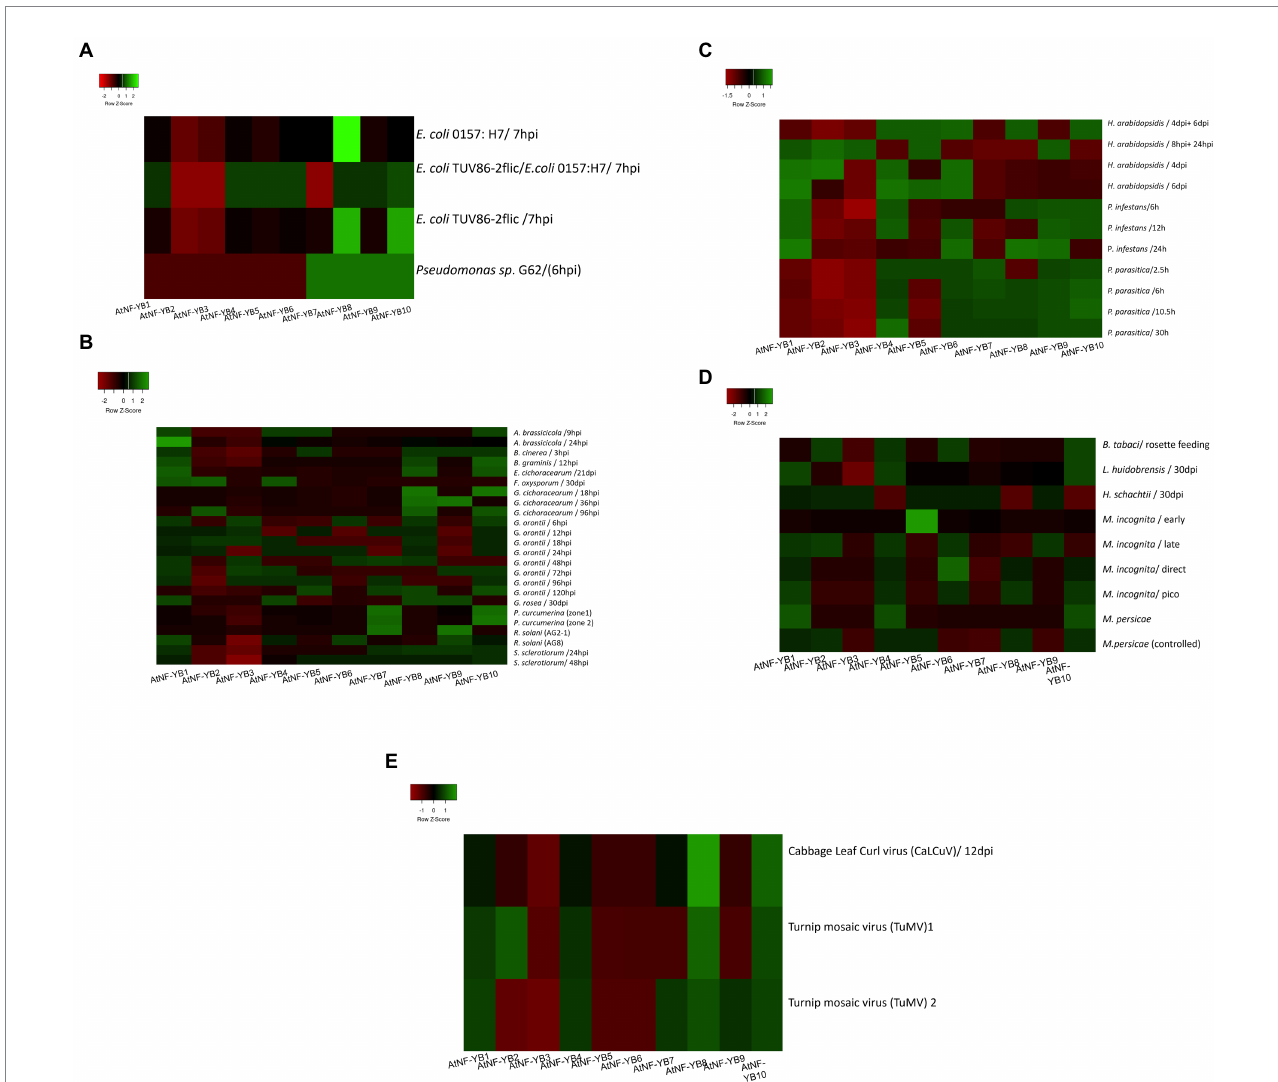
FIGURE 7 (A) Heat map showing the expression profiles of 10 AtNF-YB genes under different bacterial stress conditions. The colour scale is representative of the log2- transformed relative gene expression that is observed under control conditions. Red to green colours denote low to high relative expression levels, respectively. (B) Heat map showing the expression profiles of 10 AtNF-YB genes under different fungal stress conditions. The colour scale is representative of the log2- transformed relative gene expression that is observed under control conditions. Red to green colours denote low to high relative expression levels. (C) Heat map showing the expression profile of 10 AtNF-YB genes under different oomycete infections. The colour scale is representative of the log2- transformed relative gene expression that is observed under control conditions. Red to green colours denote low to high relative expression levels. (D) Heat map showing the expression profile of 10 AtNF-YB genes under different pest stressors. The colour scale is representative of the log2- transformed relative gene expression that is observed under control conditions. Red to green colours denote low to high relative expression levels. (E) Heat map showing the expression profile of 10 AtNF-YB genes under different plant virus infections. The colour scale is representative of the log2- transformed relative gene expression that is observed under control conditions. Red to green colours denote low to high relative expression